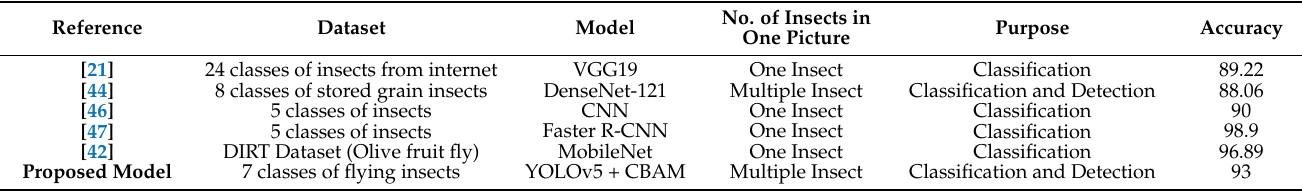
Table 4. Comparative table on various deep learning model used for insect classification and